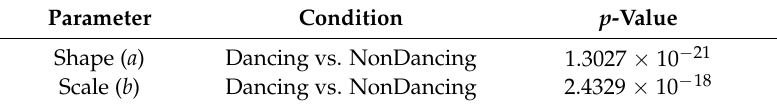
Table 1. Statistical Comparison of Dancing vs. Non-Dancing Conditions (Rank Sum